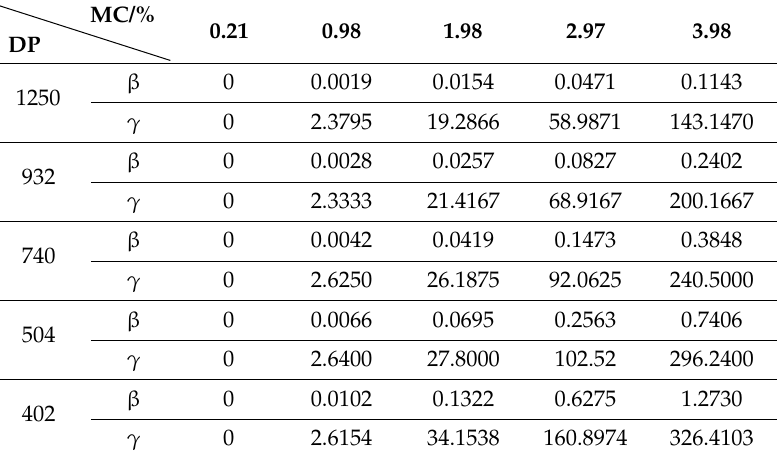
Table 4. Moisture compensation factor γ form set A~E.